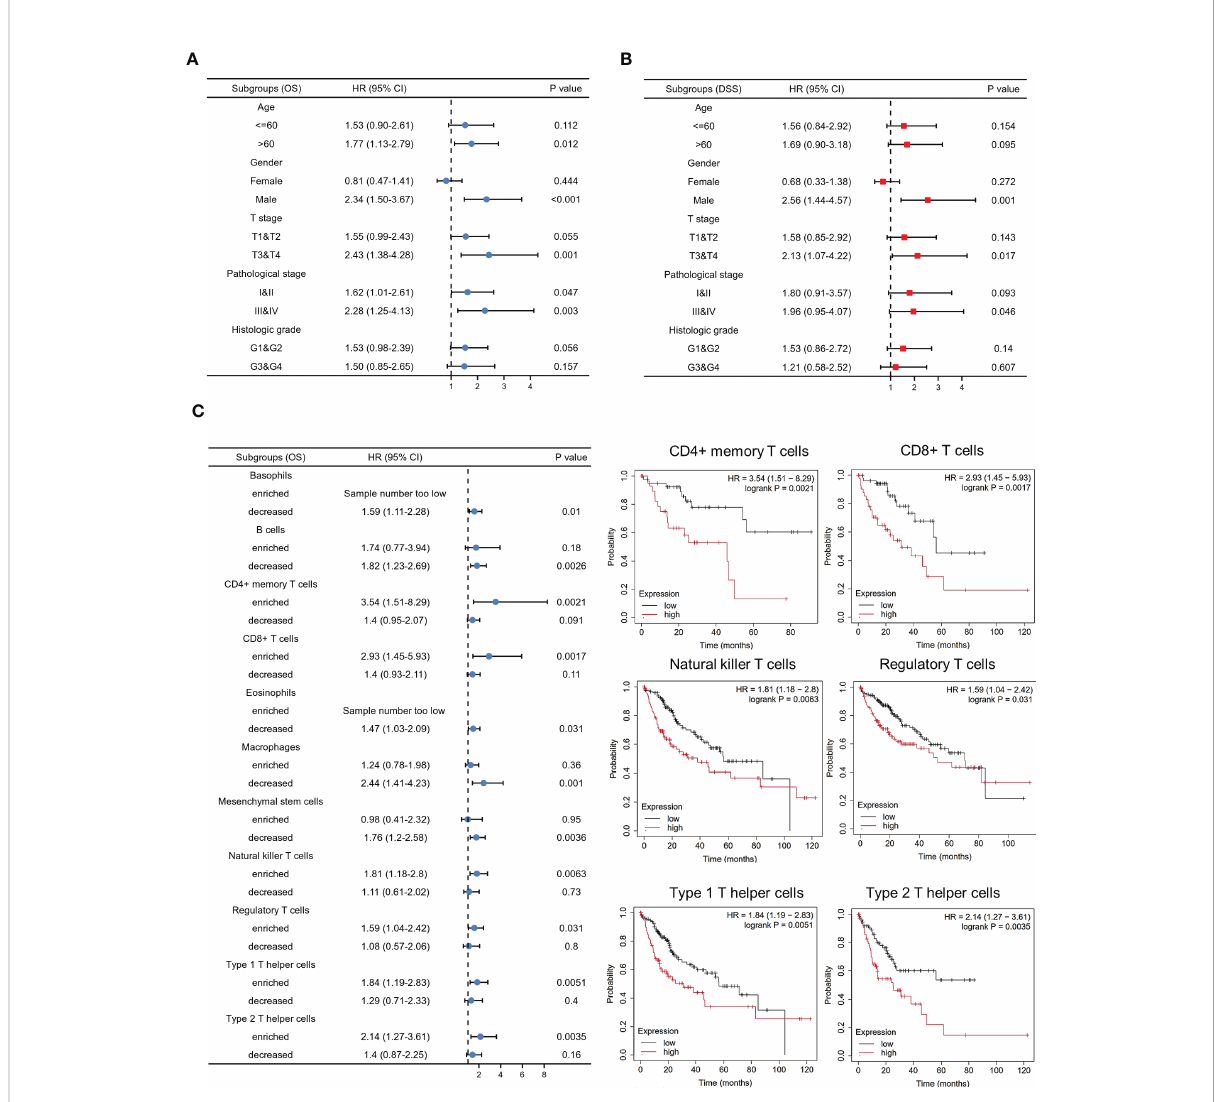
FIGURE 3 Predictive value of the KIF5A based on subgroups analyses. (A) Associations between KIF5A expression and the OS in different clinical subgroups of LIHC. (B) Associations between KIF5A expression and the DSS in different clinical subgroups of LIHC. (C) Associations between KIF5A expression and the OS in different immune in fi ltration subgroups of